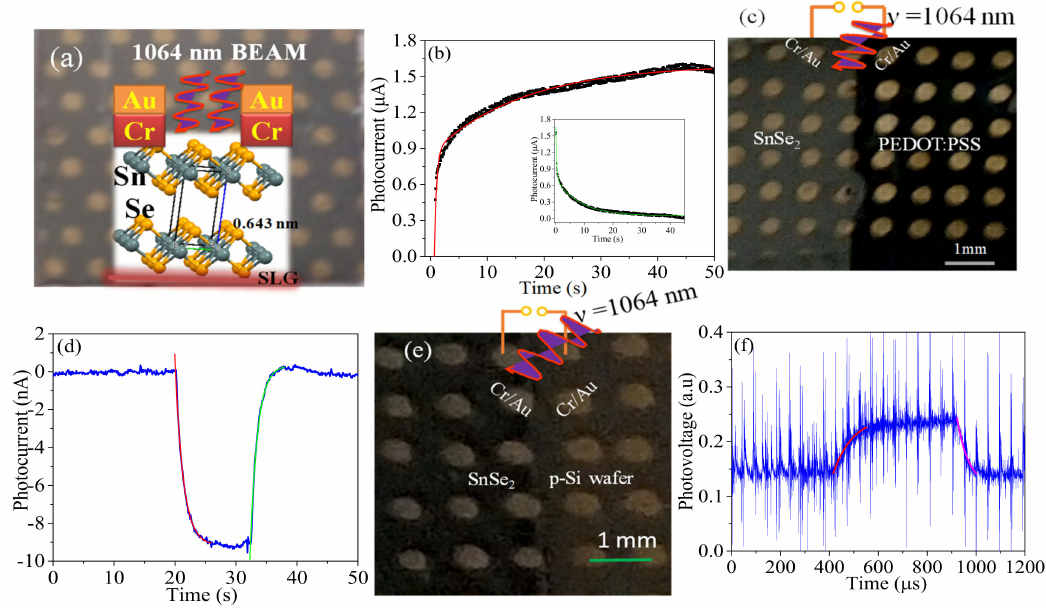
Figure 8. ( a ) Optical image of SnSe 2 on soda lime glass (SLG) substrate illuminated with 1064 nm wavelength, ( b ) Response / recovery bi-exponential fitted, ( c ) Optical image of SnSe 2 / PEDOT:PSS hetero-structure on SLG substrate, ( d ) Single exponential fitted response / recovery speeds, ( e ) Optical image of SnSe 2 / p-Si hetero-structure and ( f ) Single exponential response / recovery speed of SnSe 2 / p-Si photodiode. ( a , b ) are reproduced with permission from reference [71], ( c , d ) are reproduced with permission from reference [5], ( e , f ) are reproduced with permission from reference